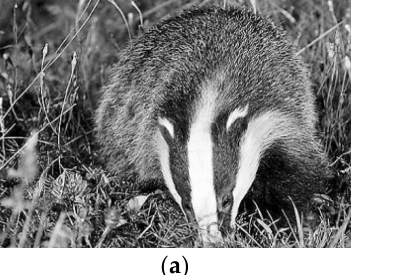
Figure 2. Schematic diagram of test equipment. ( a ) Industrial-grade 3D scanner; ( b ) laser sintering 3D printer; ( c ) DEM virtual simulation test process; ( d ) indoor soil bin test bench.